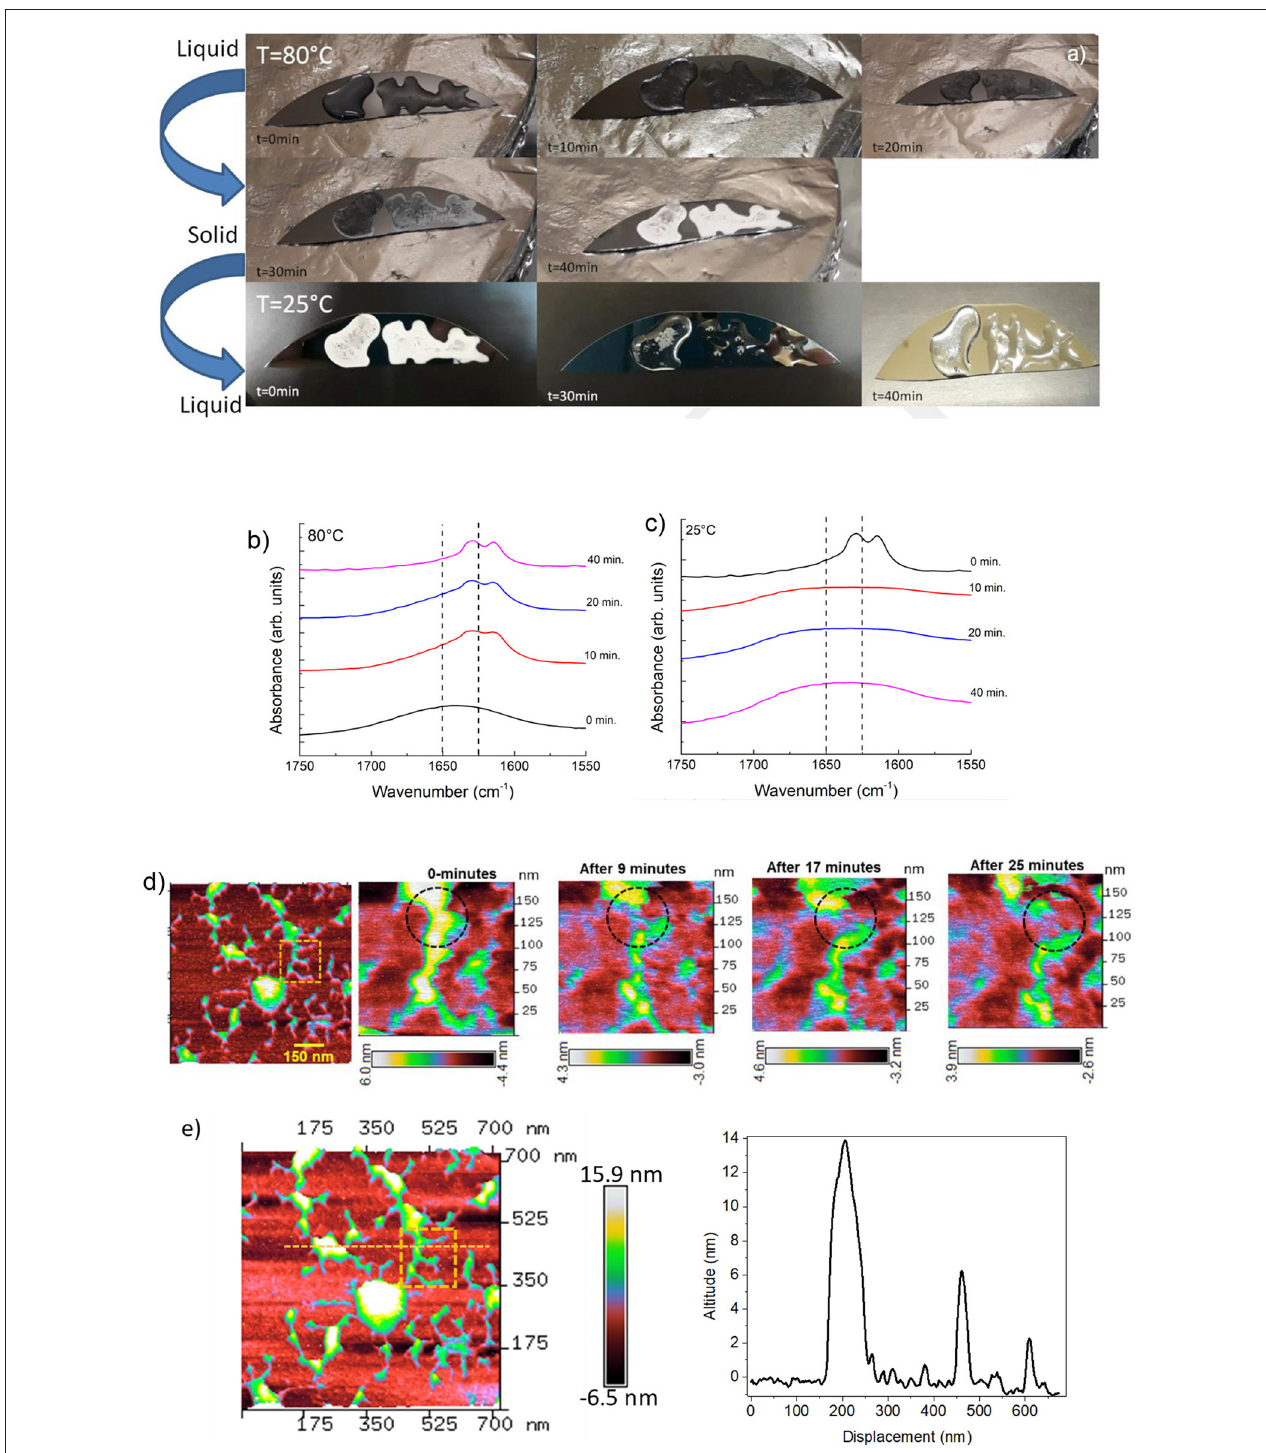
FIGURE 1 | (a) Photos showing the reversible liquid-solid transition observed along the heating/cooling time of RS. (b) ATR-FTIR spectra in the amide I region for RS liquid solution annealed at 80 ◦ C at different times. (c) ATR-FTIR spectra in the amide I region for RS solid phase cooled at room temperature at different times. (d) AFM topography of solid silk fibroin imaged at different time intervals at room temperature are showing dendritic structure of silk fibroin with several branches. The inset represents a peculiar region analyzed at different time intervals. AFM topography of a zoomed region analyzed up to 25min; a transformation in the silk-fibroin structure is marked by dashed circle. The scale bar represents the degradation of the structure as a function of time. (e) AFM image of the dendritic fibroin network; the dashed line represent the topographic profile of different altitude of the fibroin structure.